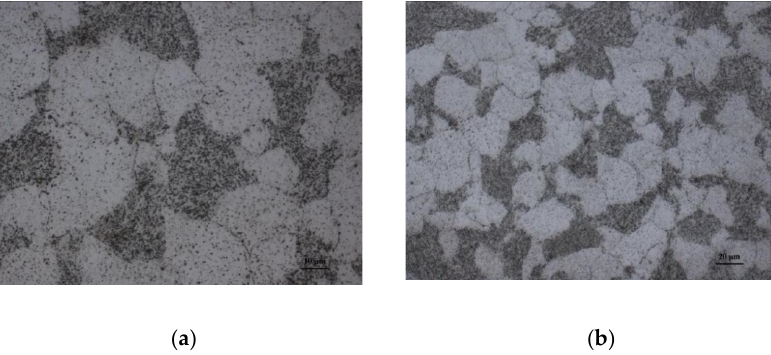
Figure 7. Metallographic structure of inner surface in the 0°direction. ( a ) 500×, ( b ) 1000×.